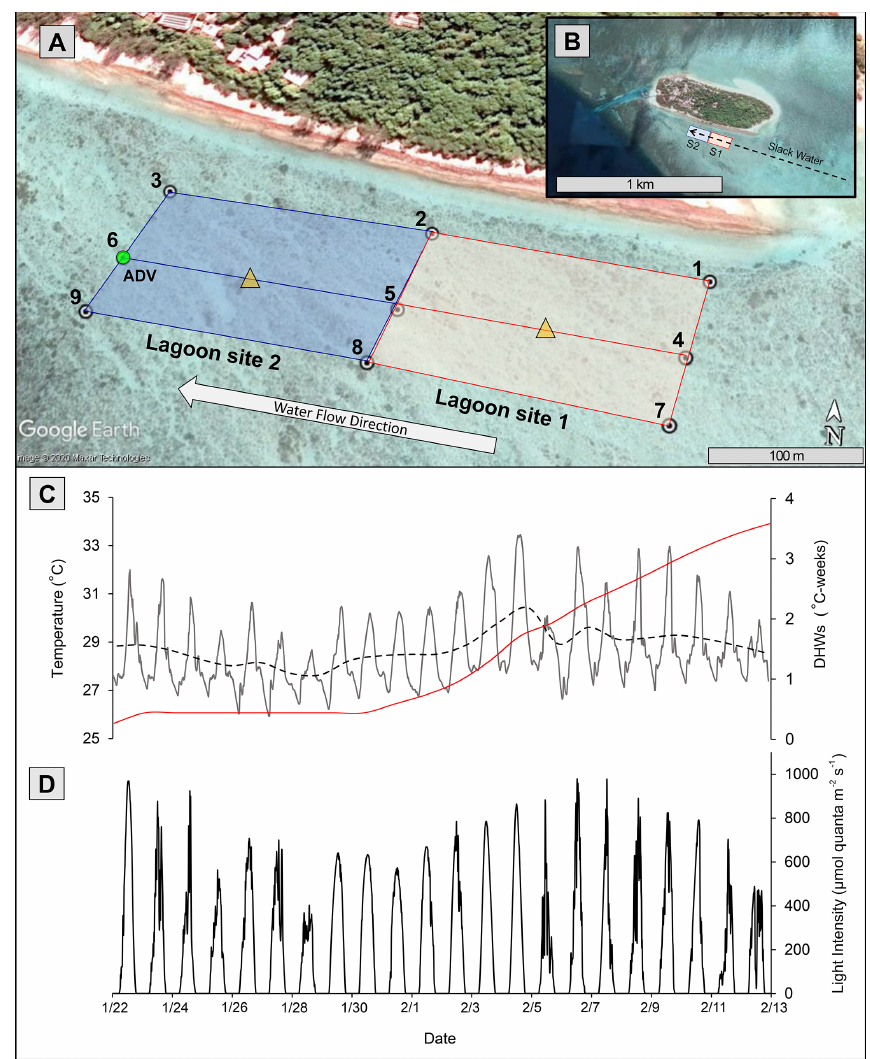
Figure 1. (a) Study area (100m scale) subdivided into lagoon site 1 (red) and lagoon site 2 (blue). Numbered white circles (1–9) indicate of location water samples and temperature loggers. Yellow triangles indicate location of light loggers. (b) Study area (1km scale) showing lagoon site 1 (S1) and lagoon site 2 (S2) in relation to Heron Island and the larger slack-water area. (c) In situ lagoon temperature ( ◦ C) averaged across both sites measured by temperature loggers. The dashed black line represents the 24h average of these temperature data, and the red line indicates the accumulation of degree heating weeks (DHWs; ◦ C weeks) in these data. (d) Light intensity (µmol quantam − 2 s − 1 ) averaged across two light loggers. The green circle represents location of ADV flow meter during Eulerian estimates. All data were recorded at 15min intervals from 22 January to 13 February 2020. Aerial photograph is provided by © Google